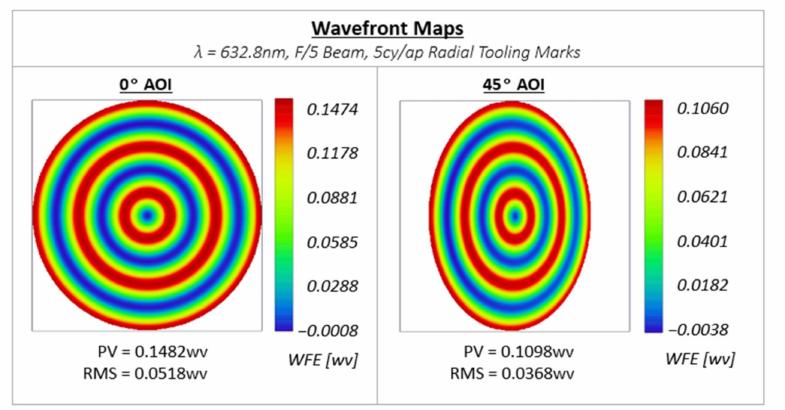
Figure 8. Example of RMS WFE dependence on mirror AOI. Test optic set as system pupil to represent a beam footprint across the whole optic, which leads to a lower projected RMS WFE.